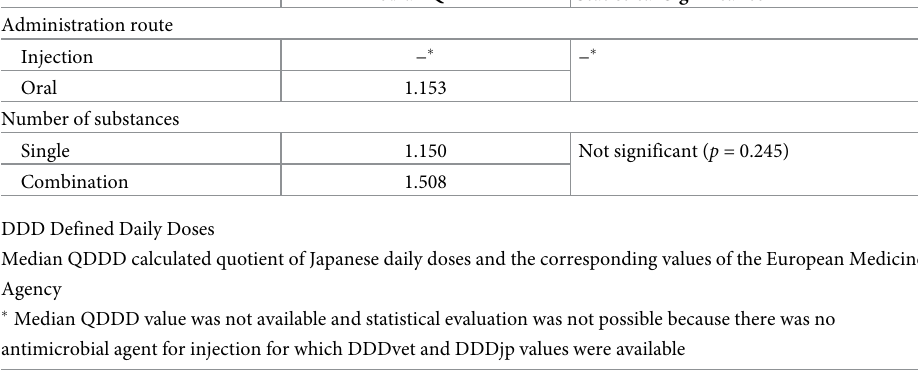
Table 8. Statistical evaluation of the calculated quotients QDDD of antimicrobial agents for use in poultry in rela- tion to administration routes and the number of active ingredients contained in the preparation (Mann-Whitney U Test).